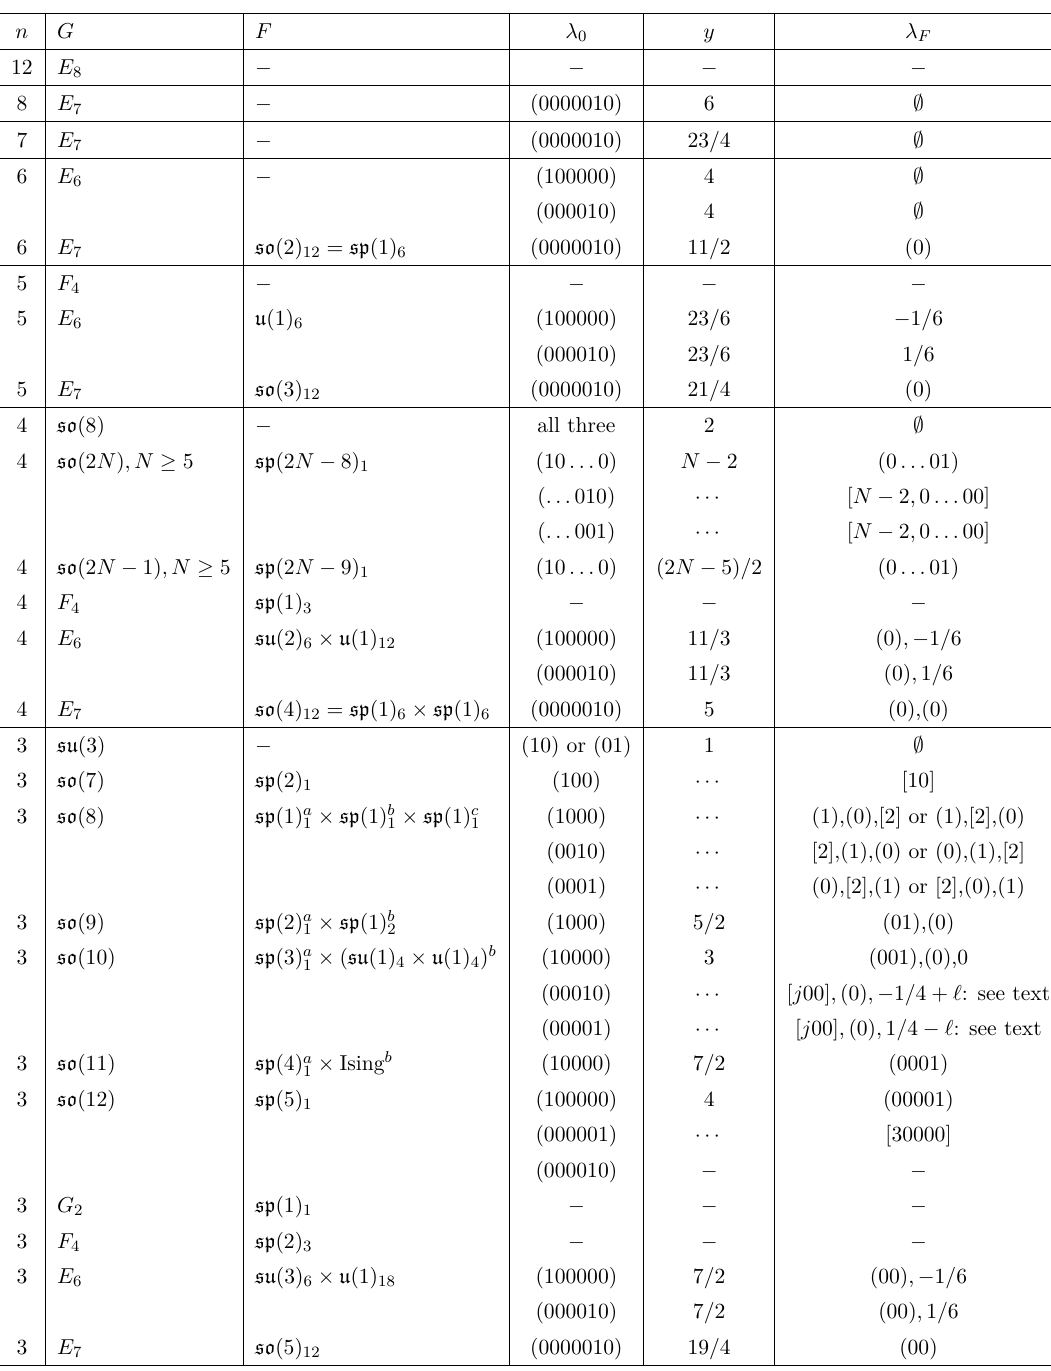
Table 7 . The parameters y, λ F of vanishing blowup equations for rank one models with n ≥ 3 . In the column of λ , the representations are labeled by their highest coweights. When a representation F is composed by many Weyl orbits, we use [ ∗ ] instead of ( ∗ ) to stress the